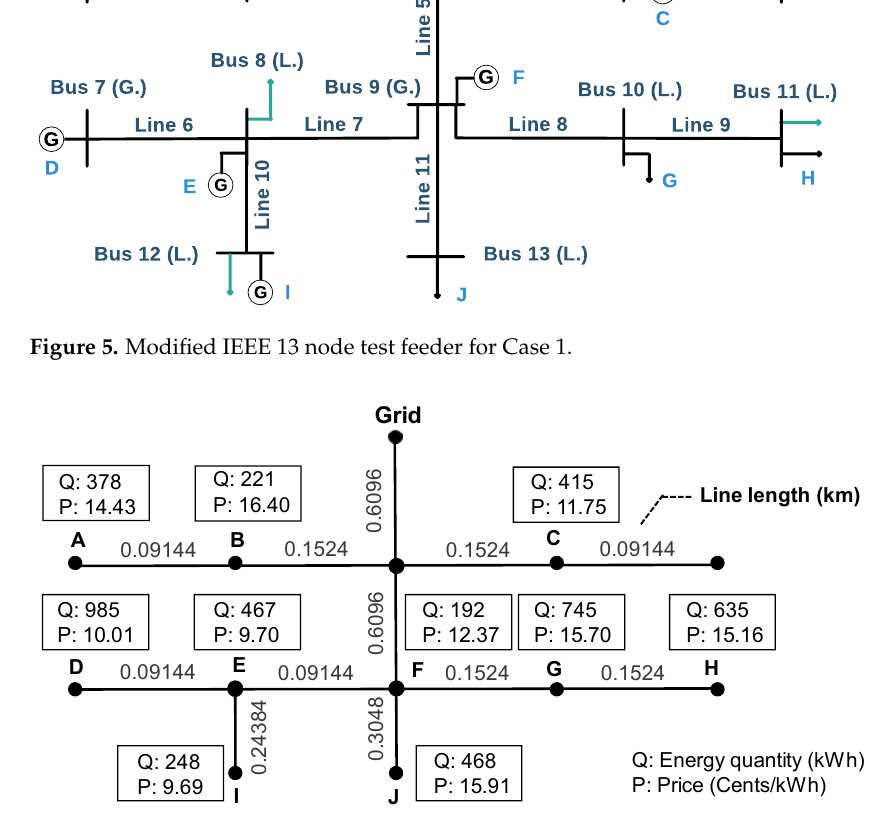
Figure 6 . Information of power quantity, price, and distance between nodes for Case 1 .